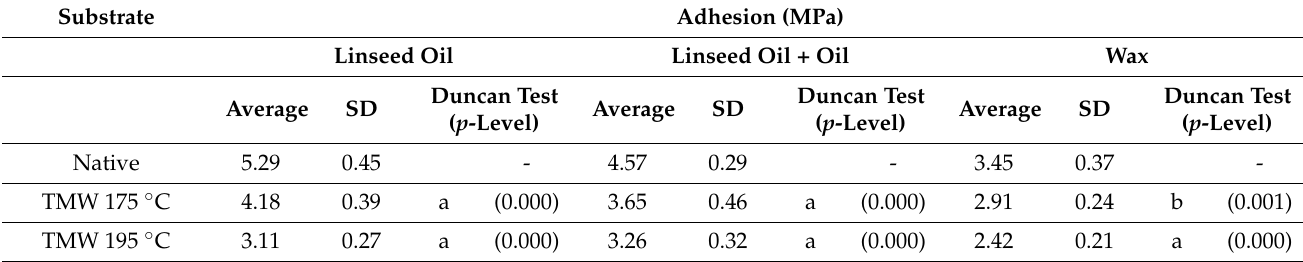
Table 7. Adhesion of the surface